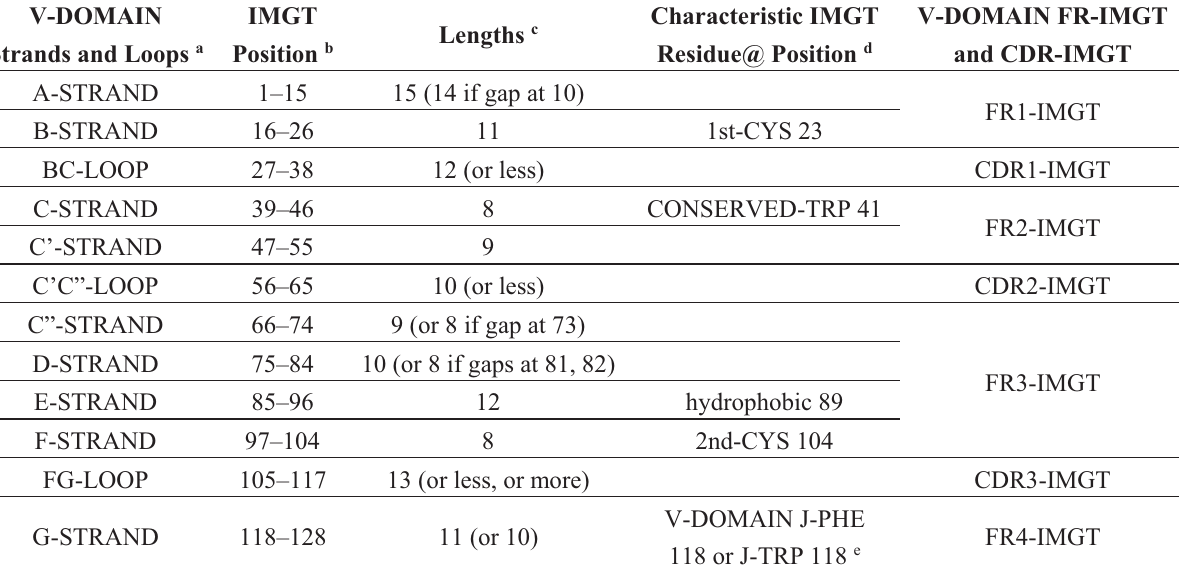
Table 2. IG V-DOMAIN strands and loops, IMGT positions and lengths, based on the IMGT unique numbering for V domain.